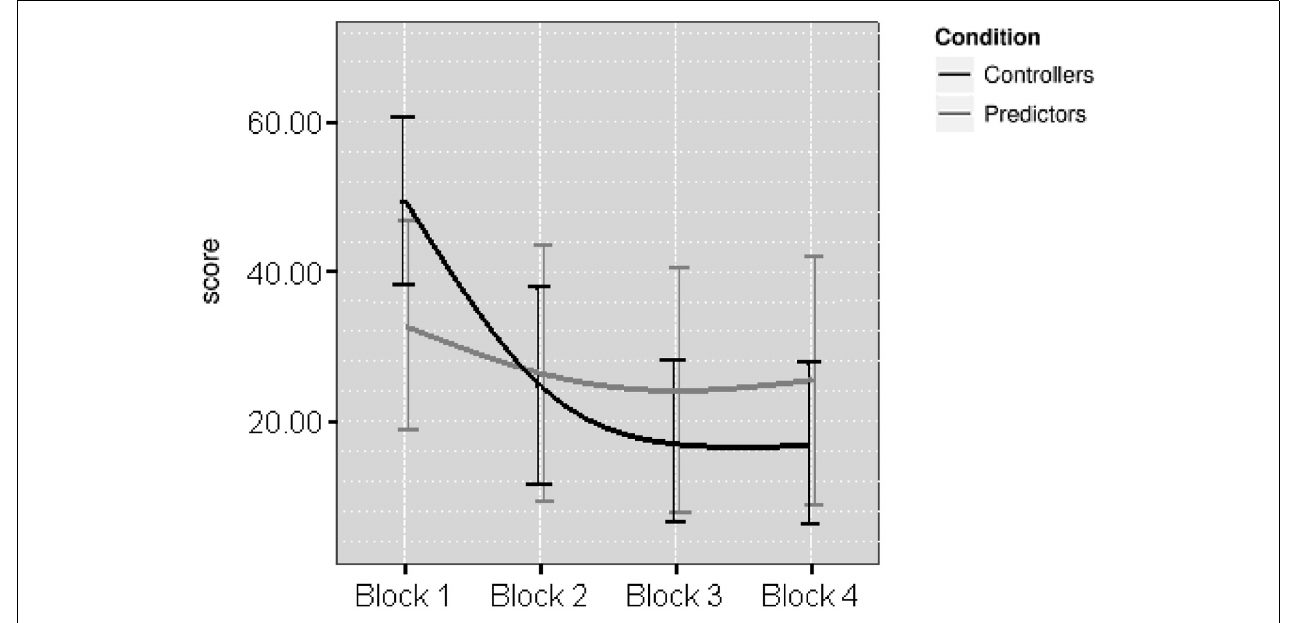
FIGURE 4 | Error scores ( ± SE) in the learning phase of Experiment 2. For Controllers, these are control error scores, and for Predictors, these are predictive error scores.